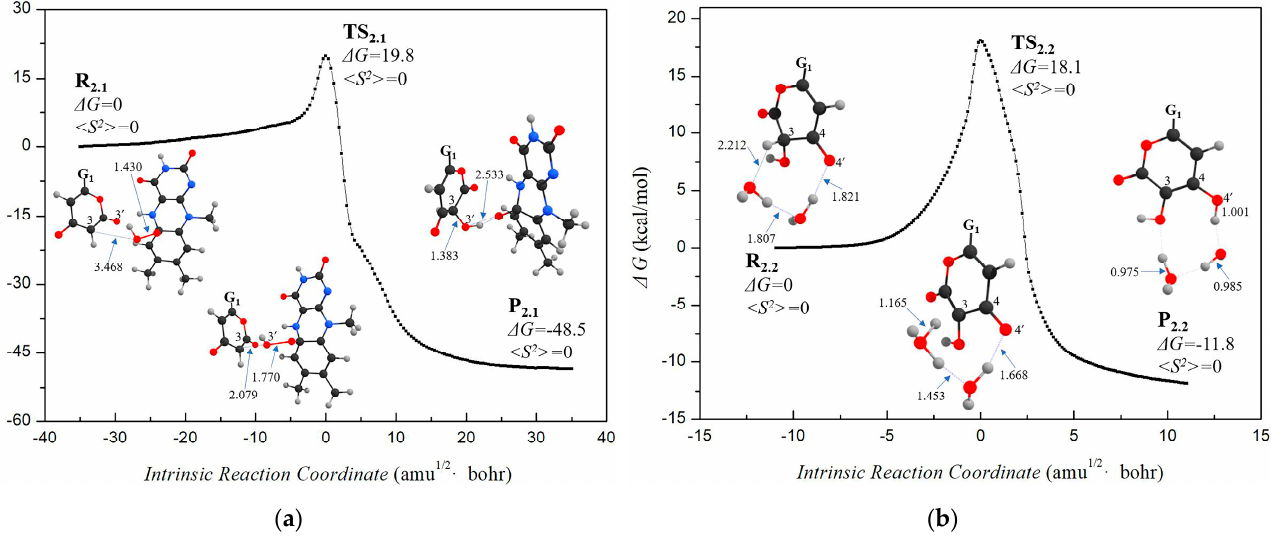
Figure 4. Under the calculated level of CAM-B3LYP/6 − 31+G**, ( a ) the reaction potential energy curve and the key geometric parameters of each stable point of ( a ) the hydroxylation process of hispidin (2.1) and ( b ) the isomerization process of 3-hydroxyhispidin (2.2). The reaction mechanism can be seen in Schemes 3–6. Group G 1 is shown in Scheme 1.